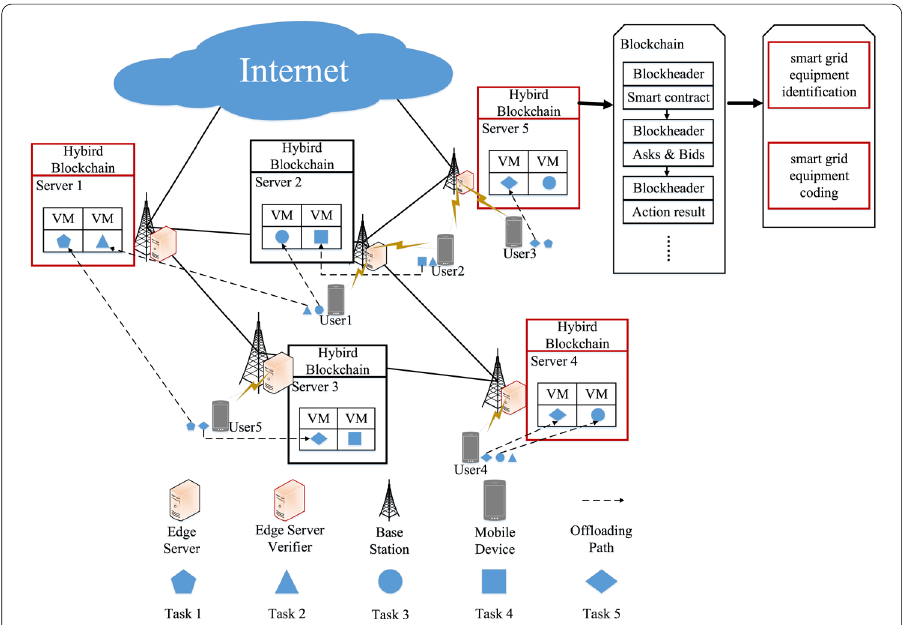
Fig. 5 A typical blockchain-driven cross-server resource allocation architecture in MEC; Illustration of A typical blockchain-driven cross-server resource allocation architecture in